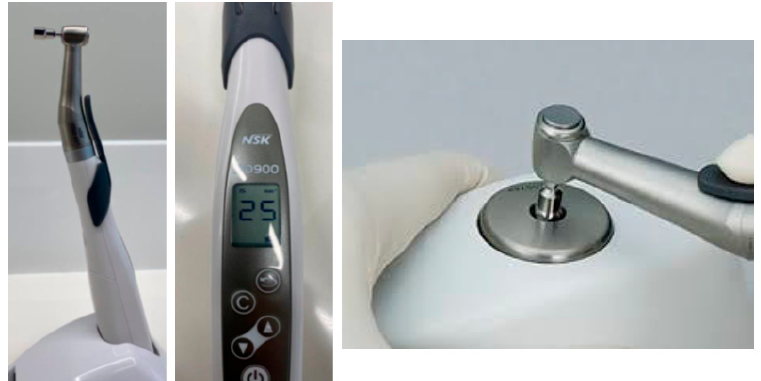
Figure 2. Prosthetic screwdriver with torque calibration system for screw fixation.